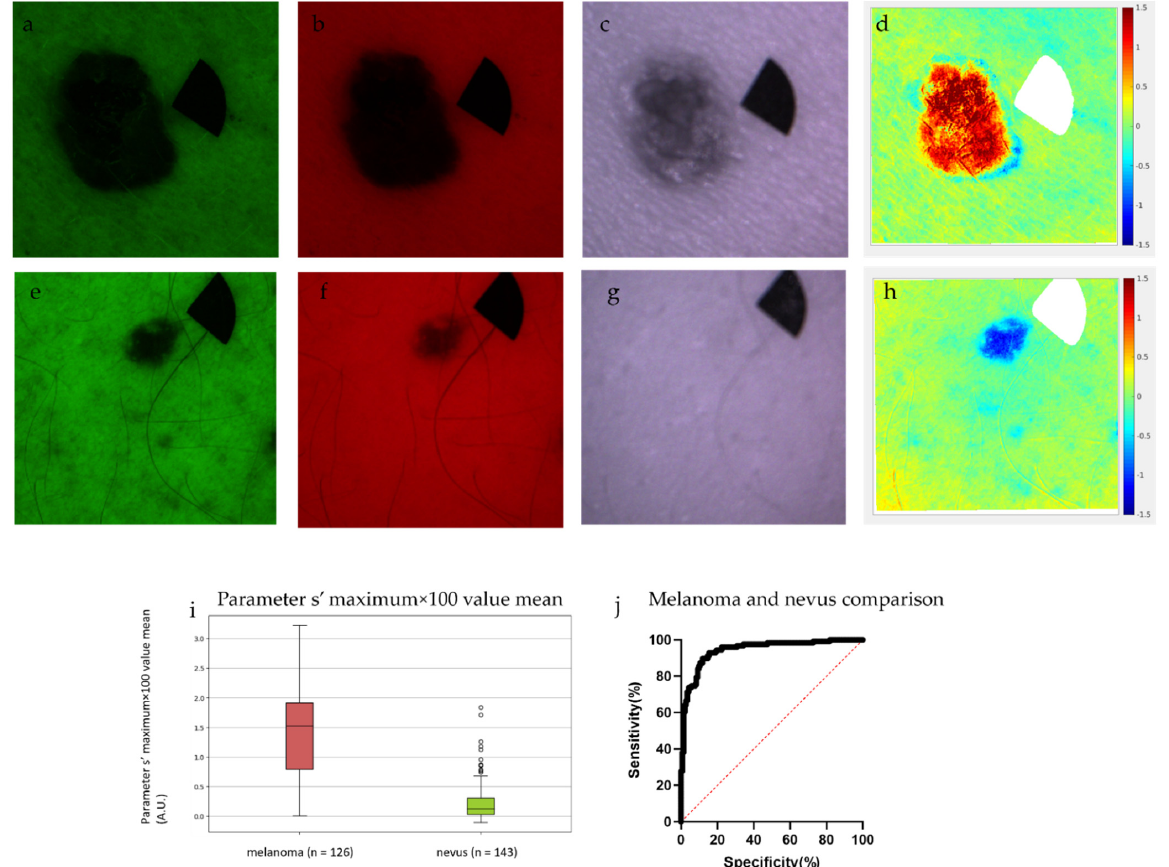
Figure 3. Differentiation of nevi from melanomas with the use of parameter s’. A superficial spreading melanoma, Breslow: 1.02, Clark: IV, pT2a (upper row), and a pigmented nevus (middle row). The parameter maps ( d , h ) were calculated using the G ( a , e ), R ( b , f ), and IR ( c , g ) channels. The melanoma with higher parameter s’ is red ( d ), whereas the nevus with its lower parameter s’ is visualized deep blue ( h ). The redness means higher probability of melanoma (highest parameter s’ is 1.5: rufous color), while blueness refers to a higher probability of nevus (lowest parameter s’ is − 1.5: deep blue color). Using the maximum values ( i ) with a threshold of 0.511 arbitrary unit (A.U.) melanomas could be differentiated from nevi with a sensitivity of 89.60% and specificity 88.11%. The area under the curve (AUC) was 0.944 (patients: melanoma, control: nevi, 95% confidence interval, p < 0.0001) ( j ). Y -axis: sensitivity, x -axis: